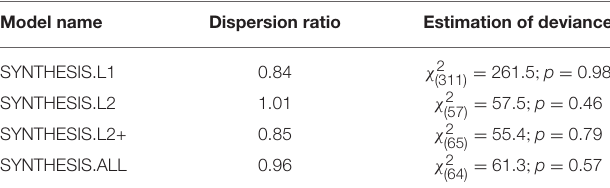
TABLE 3 | Dispersion ratio and deviance from 1 for models in case study 1.